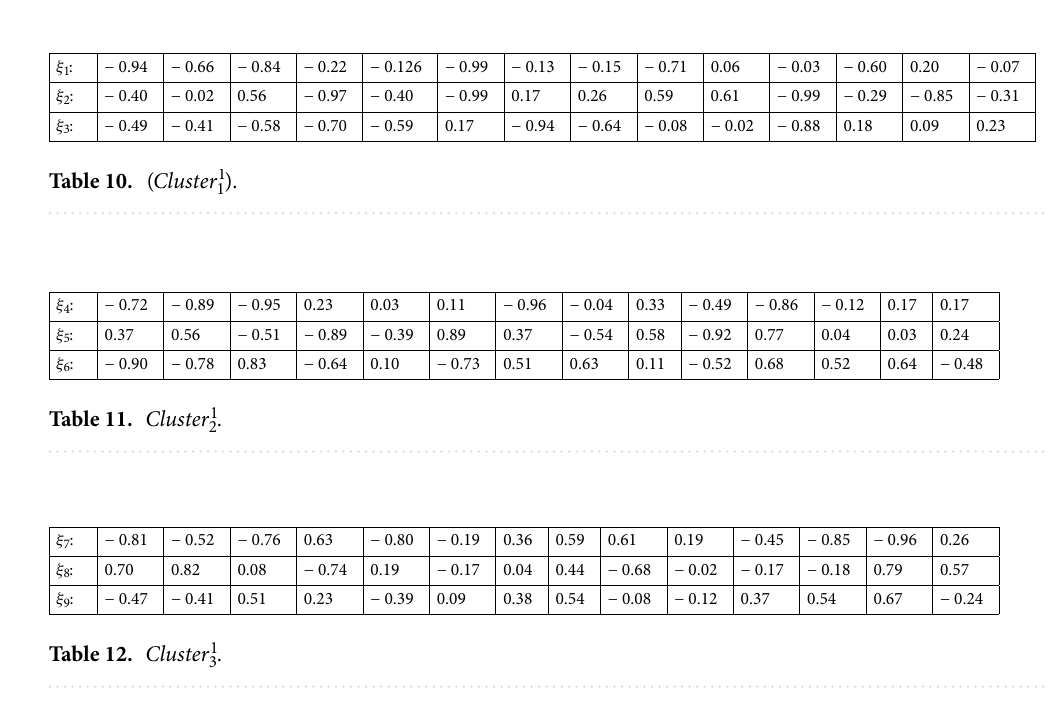
Table 9. Initial generation population ( E